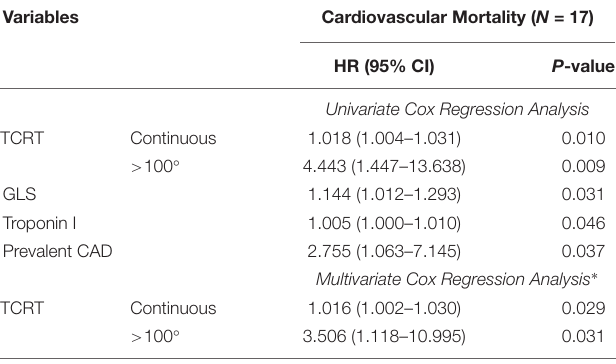
TABLE 4 | Variables associated with increased cardiovascular mortality by univariate and multivariate Cox regression analysis.